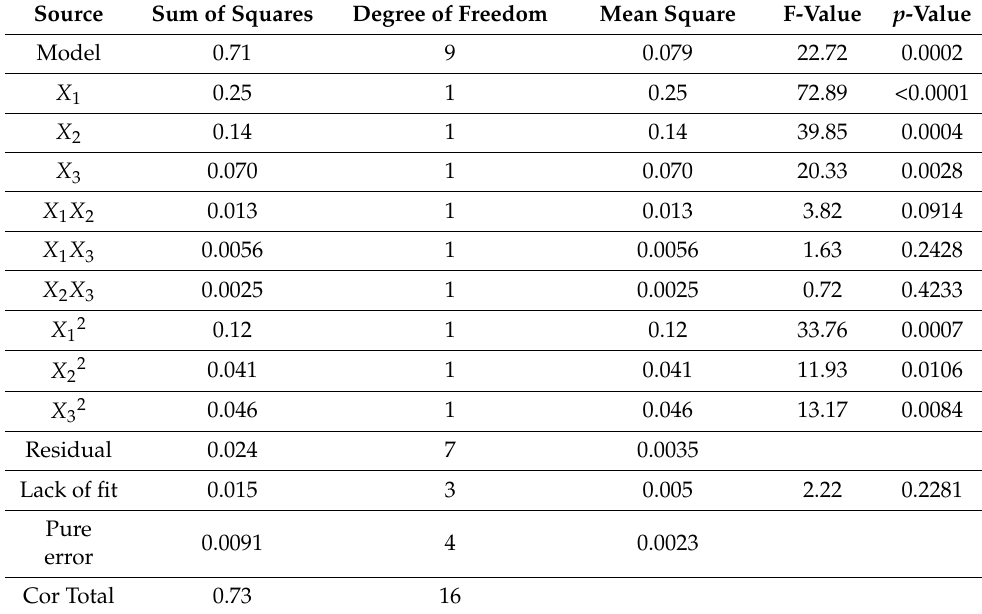
Table 5. Regression analysis of variance of Y 2